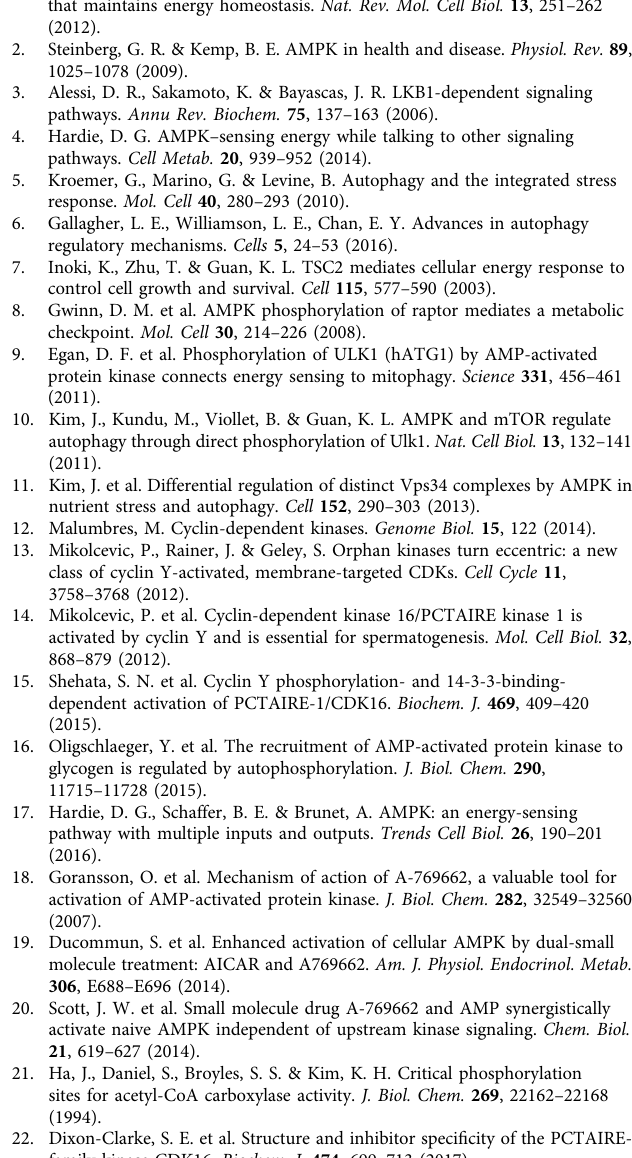
Table 1. The mass spectrometry data have been deposited to the ProteomeXchange Consortium via the PRIDE partner repository with the dataset identi fi er